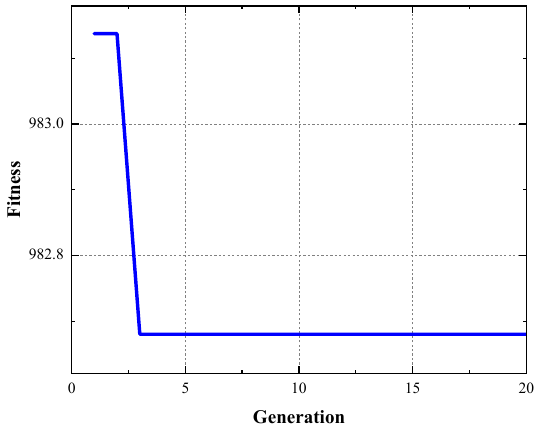
Figure 5. Fitness value of the 10 km/h constant radius test.